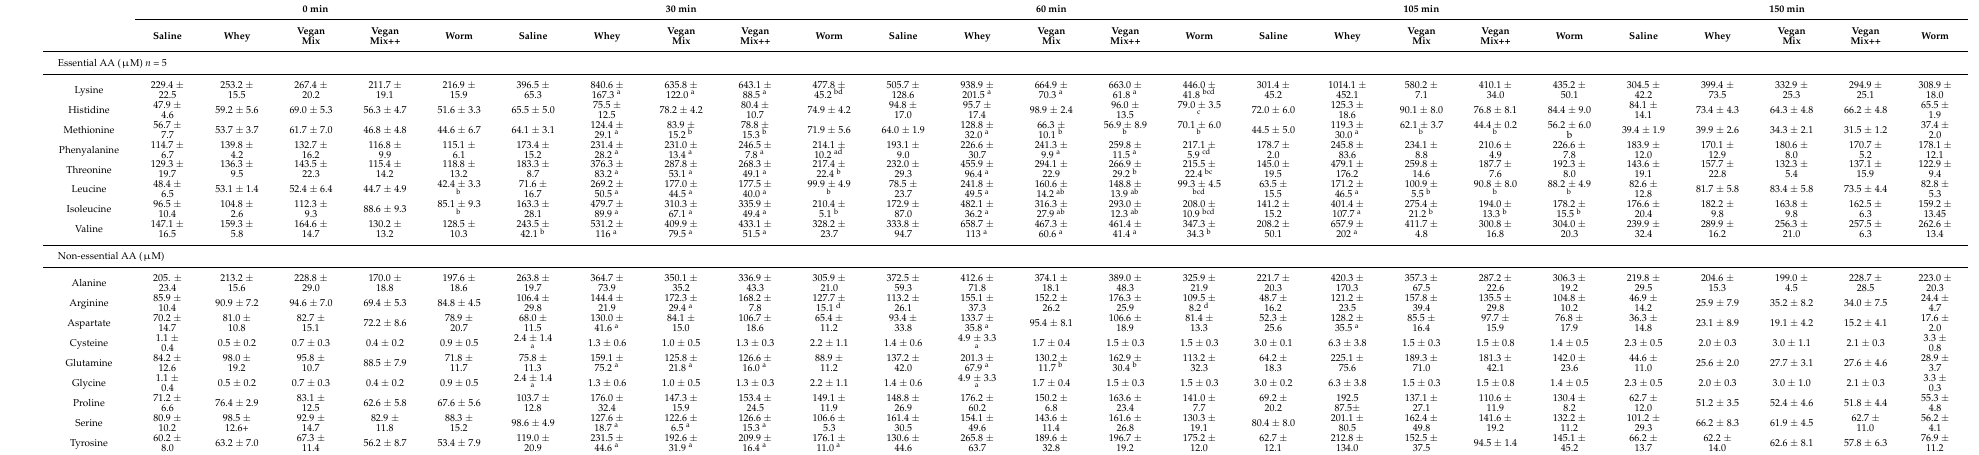
Table 2. Amino acid (AA) in blood plasma after administration of different